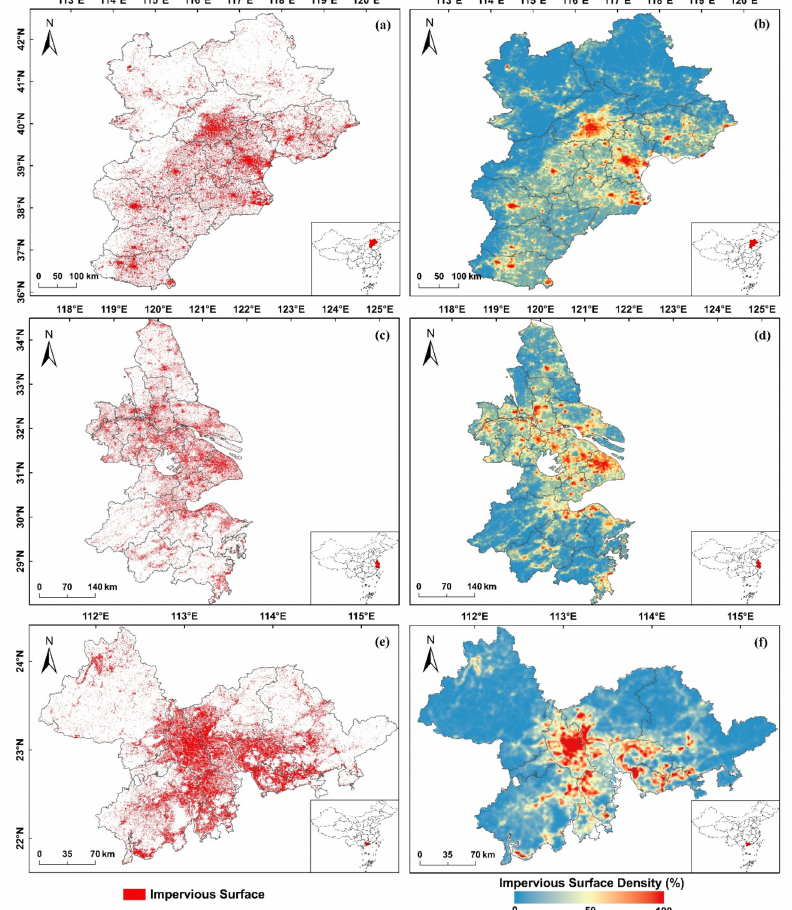
Figure 3. Spatial pattern of the impervious surface area and the density of the impervious surface area across the Beijing-Tianjin-Hebei (BTH) ( a , b ), the Yangtze River Delta (YRD) ( c , d ), and the Pearl River Delta (PRD) ( e , f ). The impervious surface area was reconstructed based on the VrNIR–BI index; and the density of the impervious surface area was reconstructed based on the Kernel